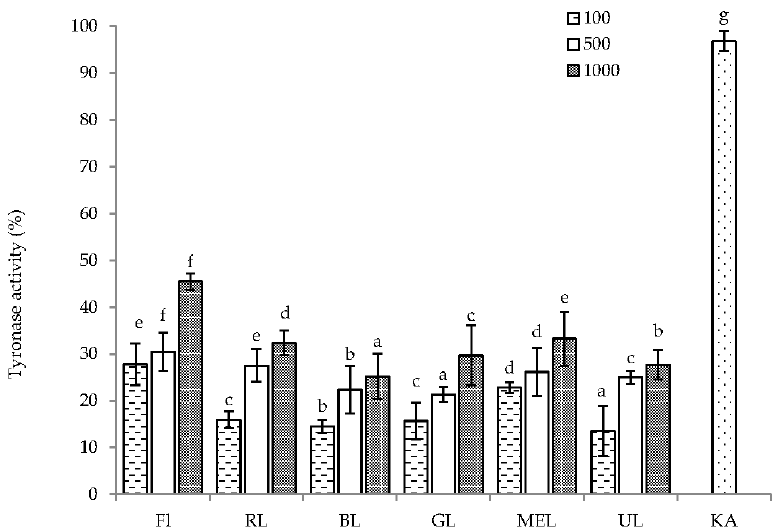
Figure 5. The effect of the peanut sprout concentration on the tyronase activity. FL: fluorescent light, RL: red LED, BL: blue LED, GL: green LED, MEL: micro-electrodeless light, UL: ultrasound+ FL, and KA: Kojic acid. Mean values within a column with the same lowercase letters were not significantly different ( p < 0.05), according to Duncan’s multiple comparison test.